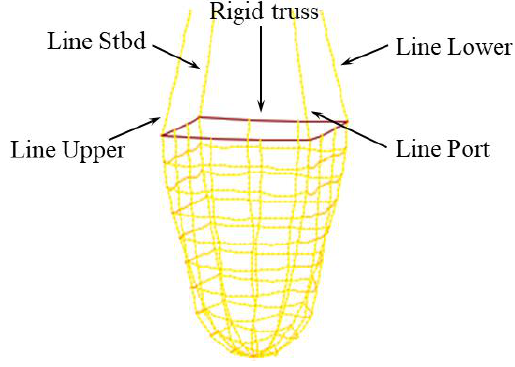
Figure 4. The rigid truss